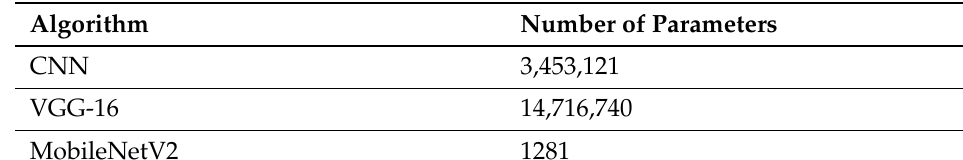
Table 4. Number of trainable parameters.